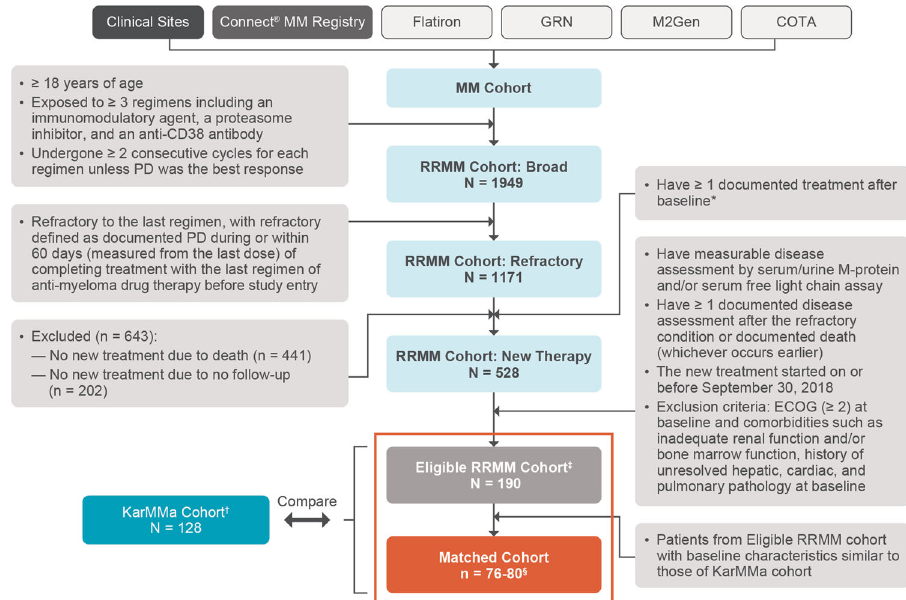
Fig. 1 Selection process for real-world Eligible Cohort. Collection of patient-level data from clinical sites, the Connect MM Registry, and external research databases, and a description of the selection process for the Eligible RRMM cohort in the KarMMa-RW study. *Baseline was de fi ned as when patients became refractory to their last regimen. † Across all ide-cel target doses in the KarMMa study (ClinicalTrials.gov: NCT03361748); at the data cutoff of 30 October 2019, 58 patients (45.3%) had discontinued from the study, 31 (24.2%) due to death, 26 (20.3%) due to study withdrawal, and 1 (0.8%) lost to follow-up. ‡ Overall, 108 patients (56.8%) discontinued from the study, all due to death. § Numbers (ranges) of matched patients from 30 imputed datasets. COTA denotes the COTA real-world evidence database, ECOG Eastern Cooperative Oncology Group, GRN Guardian Research Network, RRMM relapsed and refractory multiple